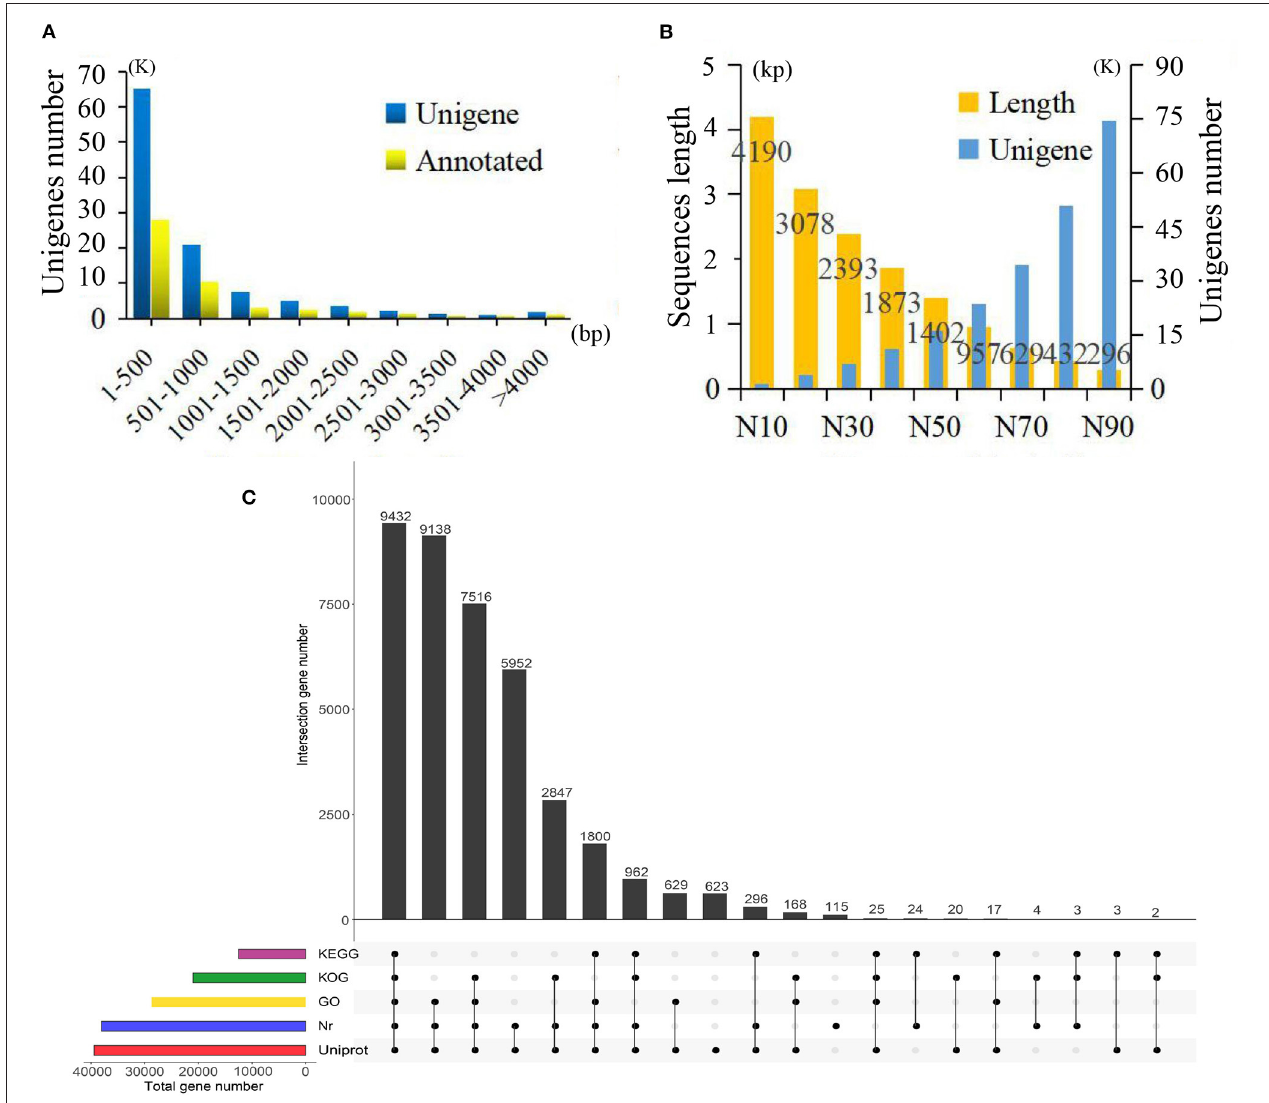
FIGURE 1 | Summary of the assembly and annotations. (A) Sequence length distribution of unigenes and annotations. (B) Sequence length and number of unigenes under different assembly indices. (C) Annotations information obtained from five different